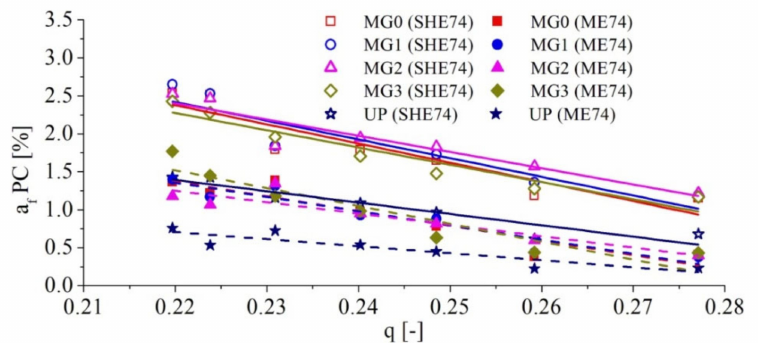
Figure 12. The dimensionless equivalent amplitude of the plunging component on the narrow band around the fundamental plunging frequency ( a f_PC ) induced by the self-induced flow instabilities on the wall of the test section at all levels (MG0, MG1, MG2, MG3 and UP) for two draft tube configurations (SHE74—solid line and ME74—dashed line) versus the discharge coefficient. Linear fits of the experimental data given by solid and dashed lines highlight the